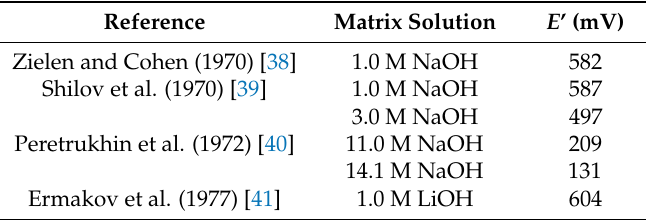
Table 1. Formal potentials reported by Zielen and Cohen [38], Shilov et al. [39], Peretrukhin et al. [40] and Ermakov et al. [41] for the redox couple Np(VII)/Np(VI) in NaOH and LiOH solutions.